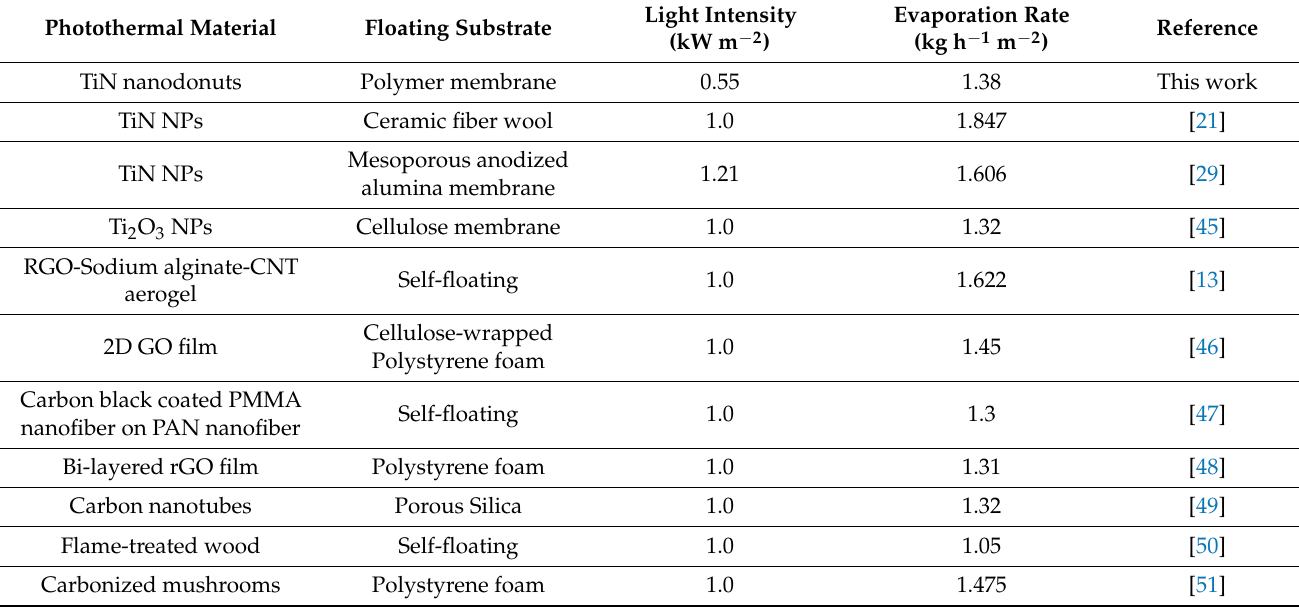
Table 1. Solar water evaporation (SWE) performance of various photothermal materials reported in the literature. Photothermal